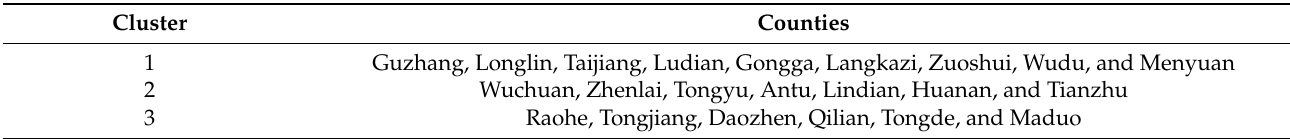
Figure 9. Clustering result of poverty-aggravated counties. Table 5. Representing counties from different